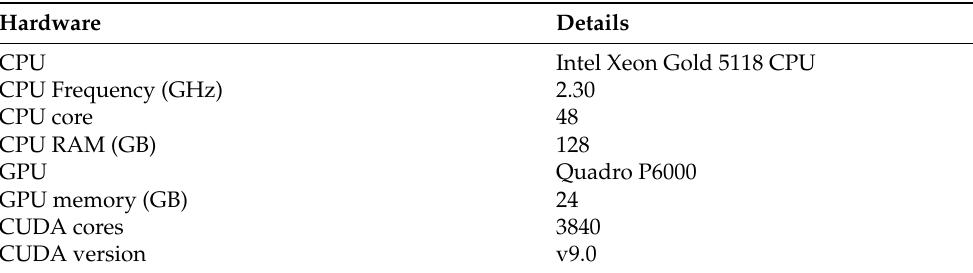
Table 2. Hardware environment configurations used in this